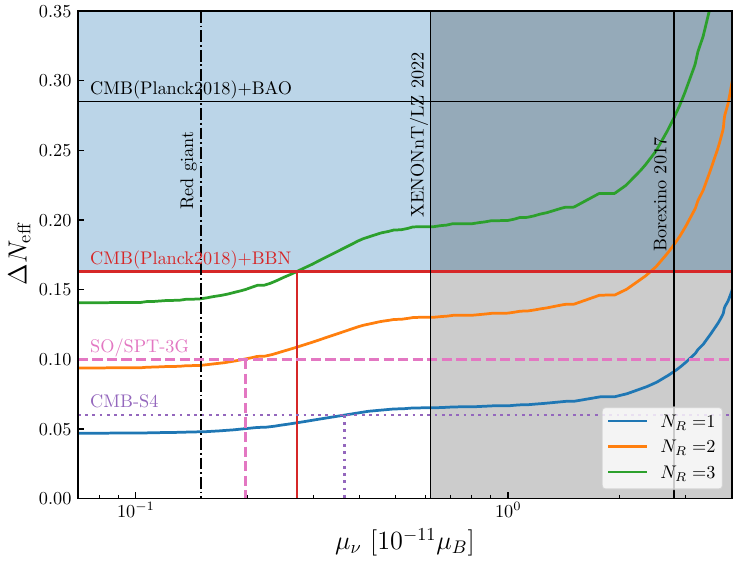
Figure 6 . The dependence of ∆ N eff on µ ν , assuming the number of ν R thermalized via NMM is N R = 1 , 2 , or 3 . The red horizontal line represents the current best limit on ∆ N eff from the combination of latest CMB (Planck 2018) and BBN data. For N R = 3 , it can be recast to the corresponding bound on µ ν , as indicated by the red vertical line. Future experiments such as SO/SPT-3G and CMB-S4 will be able to probe the N R = 2 and N R = 1 scenarios. Other constraints are explained in the